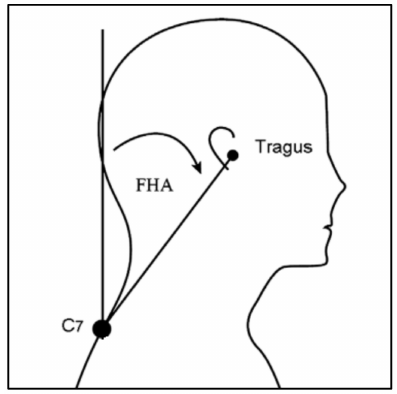
Figure 2. Forward head angle measured from the vertical anteriorly to a line connecting the tragus and the C7